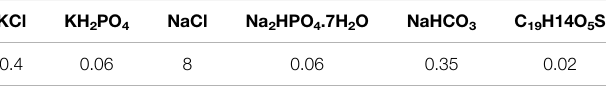
TABLE 1 | The composition of D-Hank ’ s solution